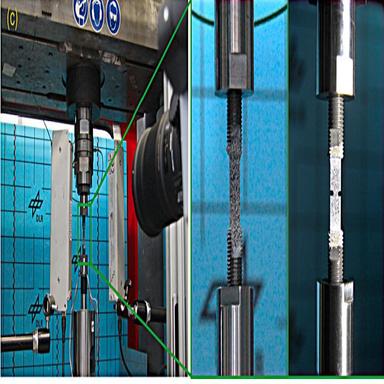
Test set-ups for: (a) quasi-static testing of ± 45◦ tensile specimens; (b) quasi-static testing of DENT specimens; and (c) intermediate strain rate testing of both specimen types and a zoom up image: in-plane shear (left) and DENT (right) specimens.